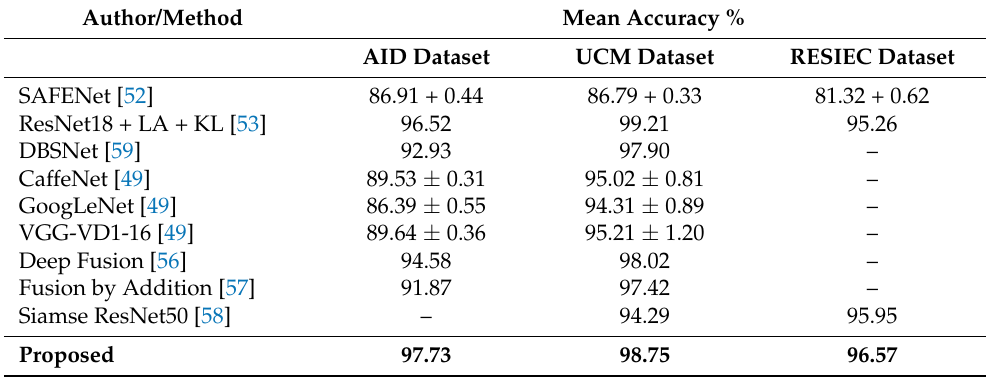
Table 5. Comparison of scene classification accuracies of SOTA methods with the proposed OCSC